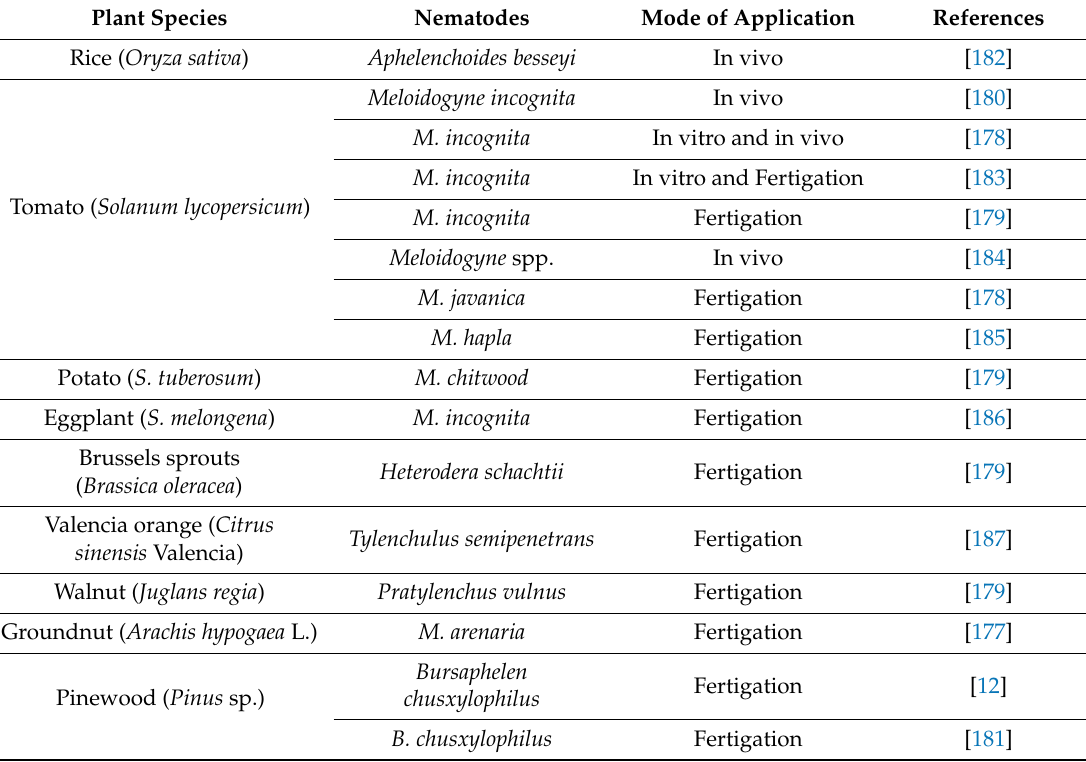
Table 5. Nematicidal e ff ect of CHT on nematode plant